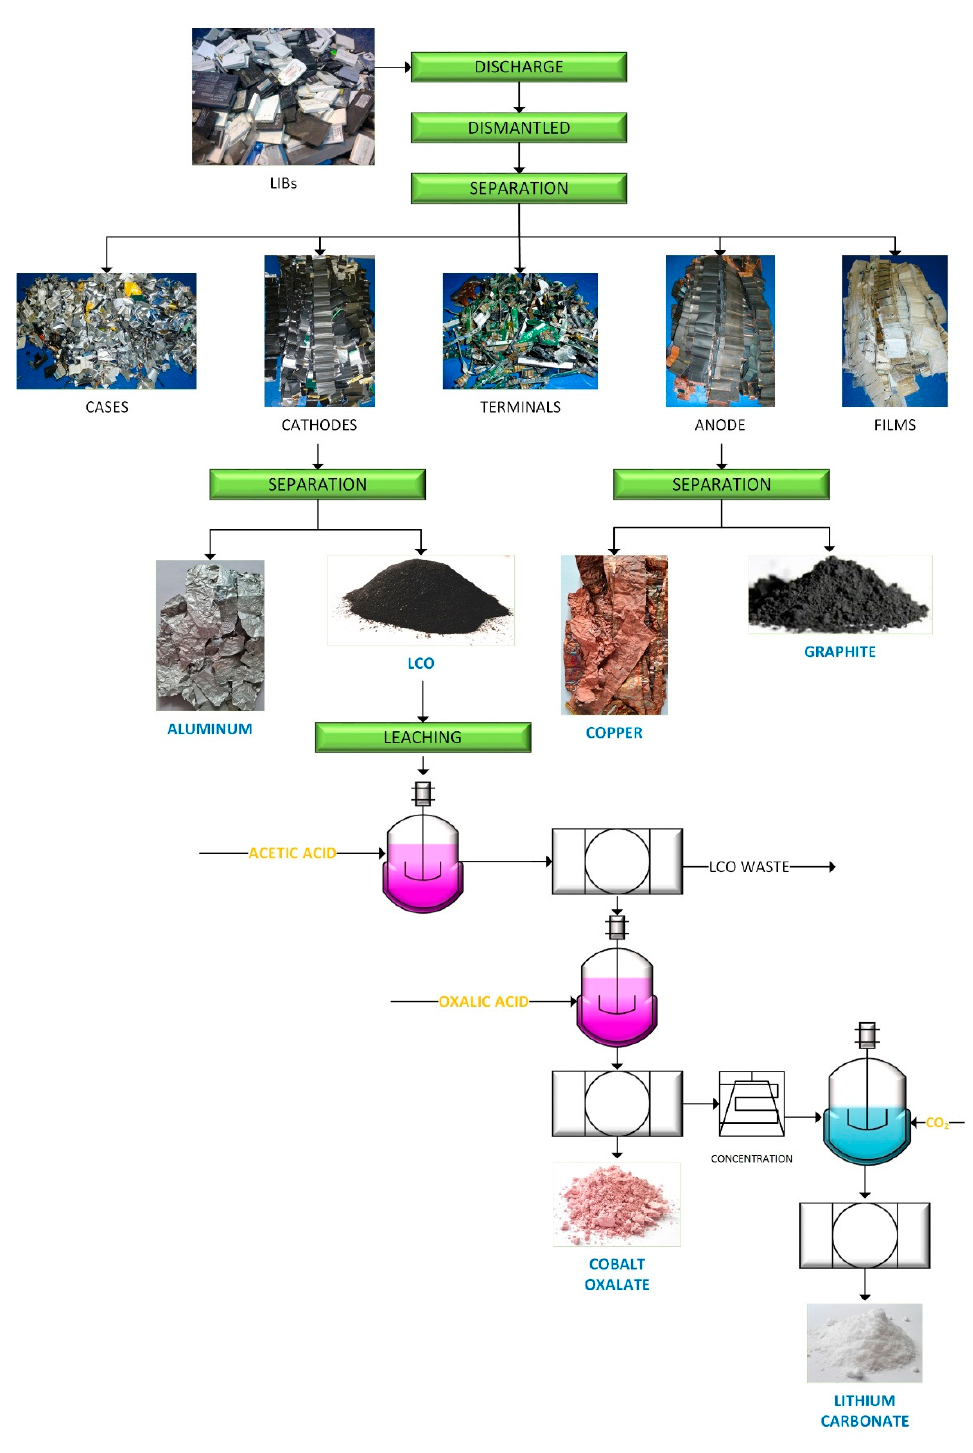
Figure 1. Process flow